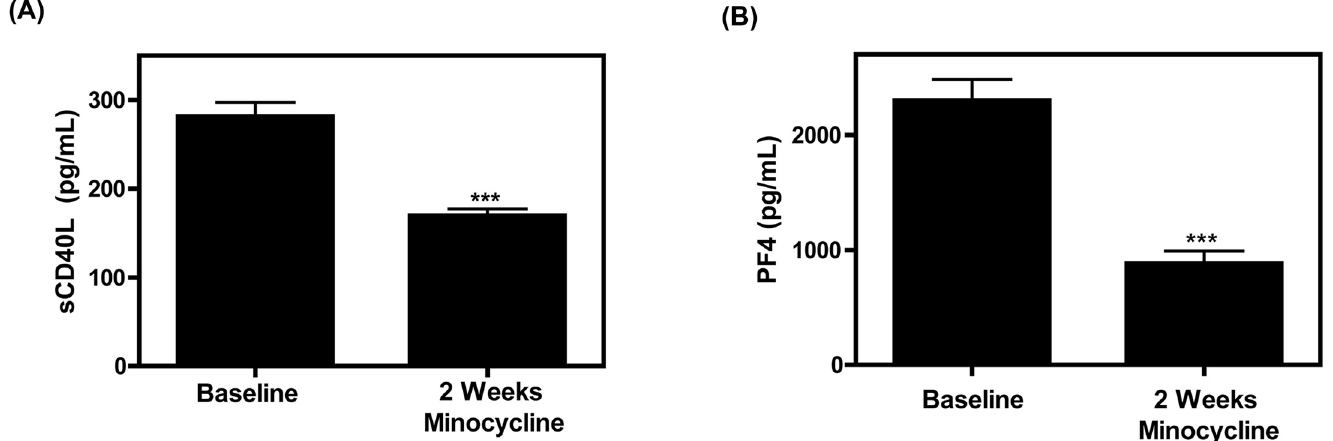
Fig 1. Minocycline treatment reduces sCD40L and PF4 levels in HIV-infected individuals. (A) Plasma sCD40L and (B) plasma PF4 levels were analyzed in HIV-infected individuals (n = 12) receiving cART and an additional treatment of minocycline at a dose of 200mg/day. Baseline corresponds to plasma levels measured at week zero as compared to plasma levels measured after 2 weeks of adjunctive minocycline treatment. The samples were compared using a student ’ s t test with a 95% confidence interval, where *** denotes p < 0.0001.